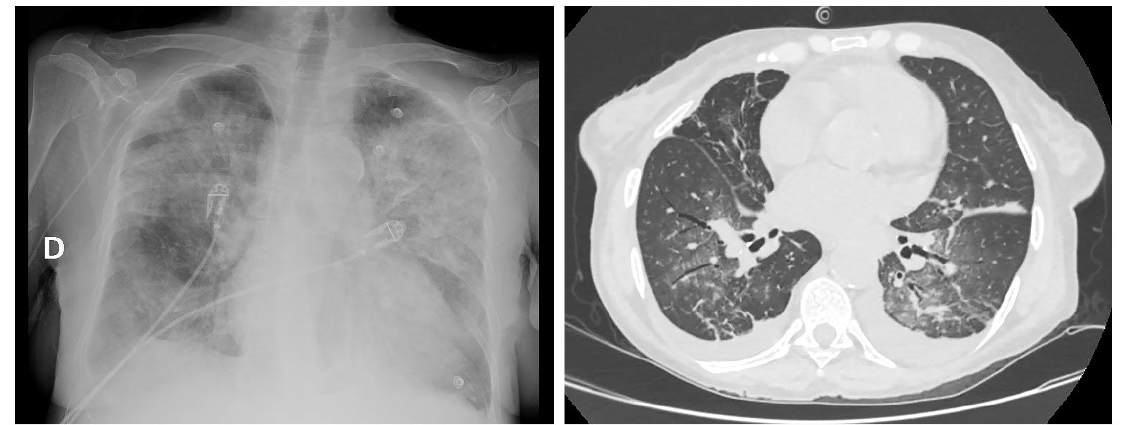
Figure 3. Chest X-ray and TC scan documenting bilateral pulmonary infiltrates and pleural effusion during ATRA differentiation syndrome (Carestream Vue Motion Version 12.1.5.9529 © Carestream Health, Inc., Rochester, NY, USA, 2021).